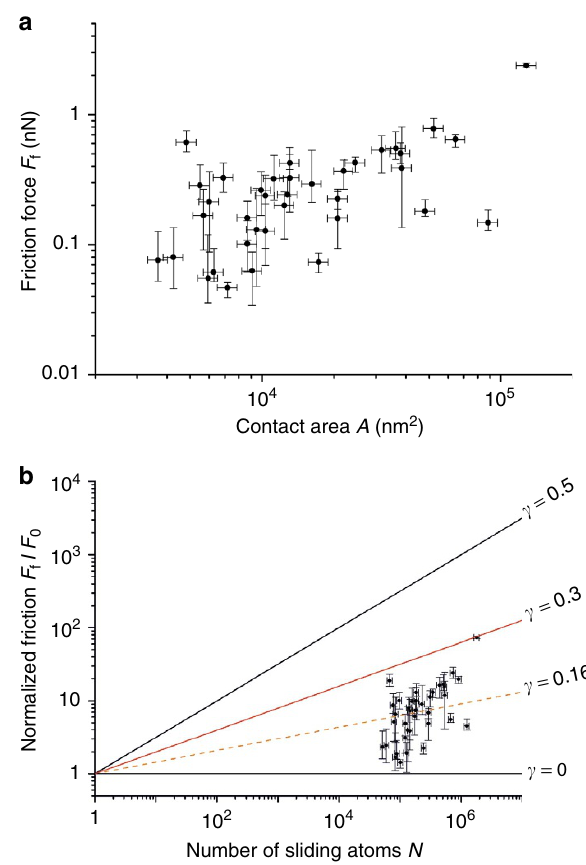
Figure 3 | Structural lubricity under ambient conditions. ( a ) Interfacial friction force ( F f ) values for 37 manipulation events plotted as a function of contact area A . ( b ) Normalized friction force values ( F f / F 0 ) plotted as a function of number of atoms on the sliding gold surface N . All manipulation events fall clearly ( g r 0.3) within the regime defined for structural lubricity (0 o g o 0.5), with a mean scaling power of g ¼ 0.16. The relatively large spread in the data is attributed to the variability in the circumferential shape of the gold islands, with some islands exhibiting more straight facets and sharper corners than others 11 . Horizontal error bars of ± 10% are imposed on A and N values due to tip-convolution effects 44 . Vertical error bars associated with F f and F f / F 0 values are directly extracted from individual manipulation events as in Fig.